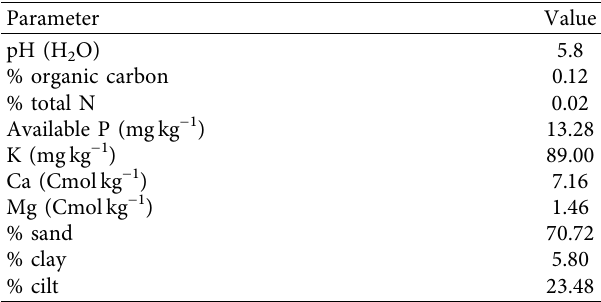
Table 1: Physical and chemical properties of the soil of the trial site at Nyankpala, northern